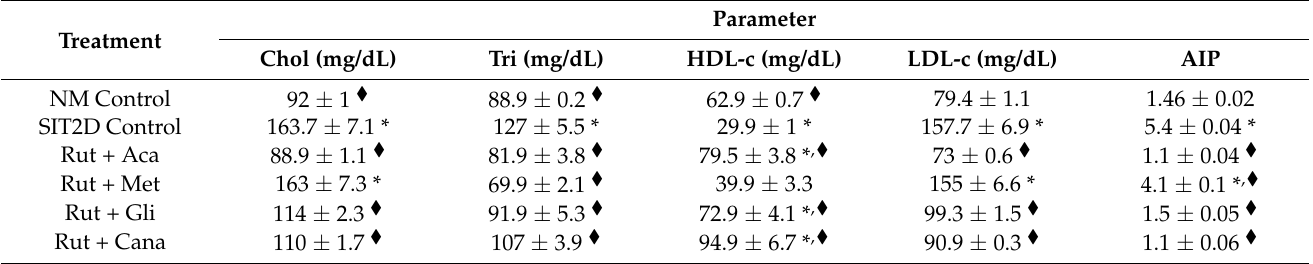
Table 4. Lipid profile values of groups treated with oral antidiabetic drugs in combination with rutin. Treatment